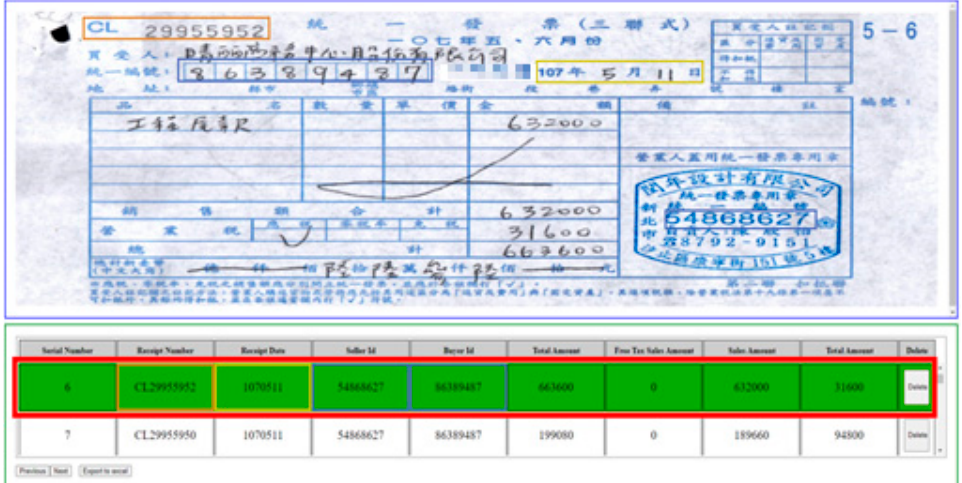
Figure 21. System interface for handwritten receipts .